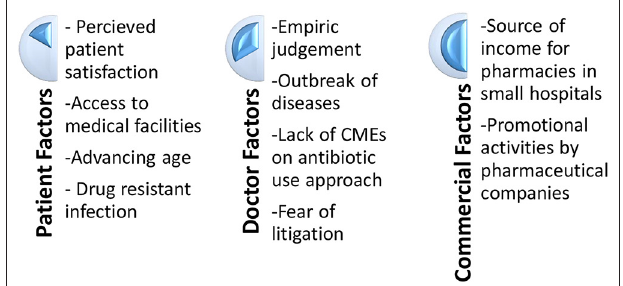
FIGURE 1 | Factors for inappropriate use of